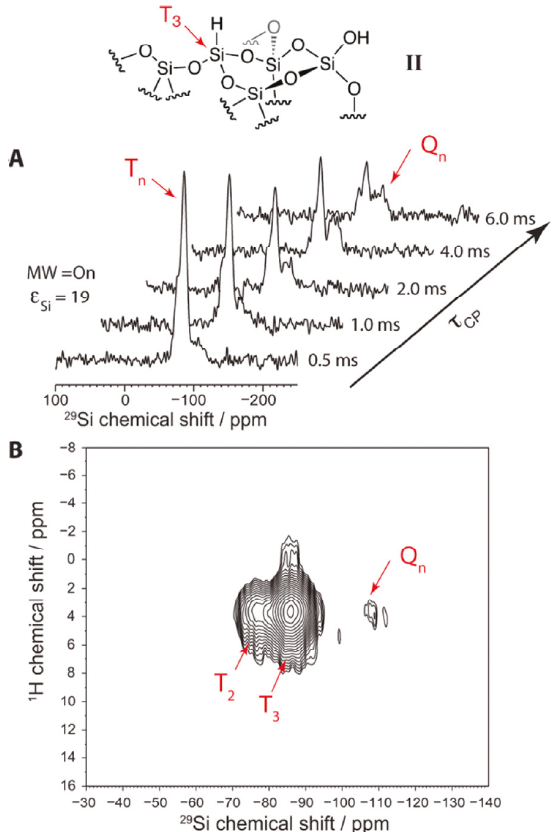
Figure 10. ( A ) Dynamic nuclear polarization (DNP)-enhanced 29 SiCross-Polarization Magic Angle Spinning (CPMAS) NMR spectra of II as a function of the CP mixing time τ CP . Spectra were recorded with 16 scans. ( B ) Contour plot of a two-dimensional 1 H– 29 Si spectrum of II recorded with DNP. 64 t 1 increments of 64 µ s with eight scans each were recorded with τ CP = 1.0 ms. Total experimental time was 8.5 min. (Reprinted with permission from Reference [49]. © 2011 American Chemical Society).